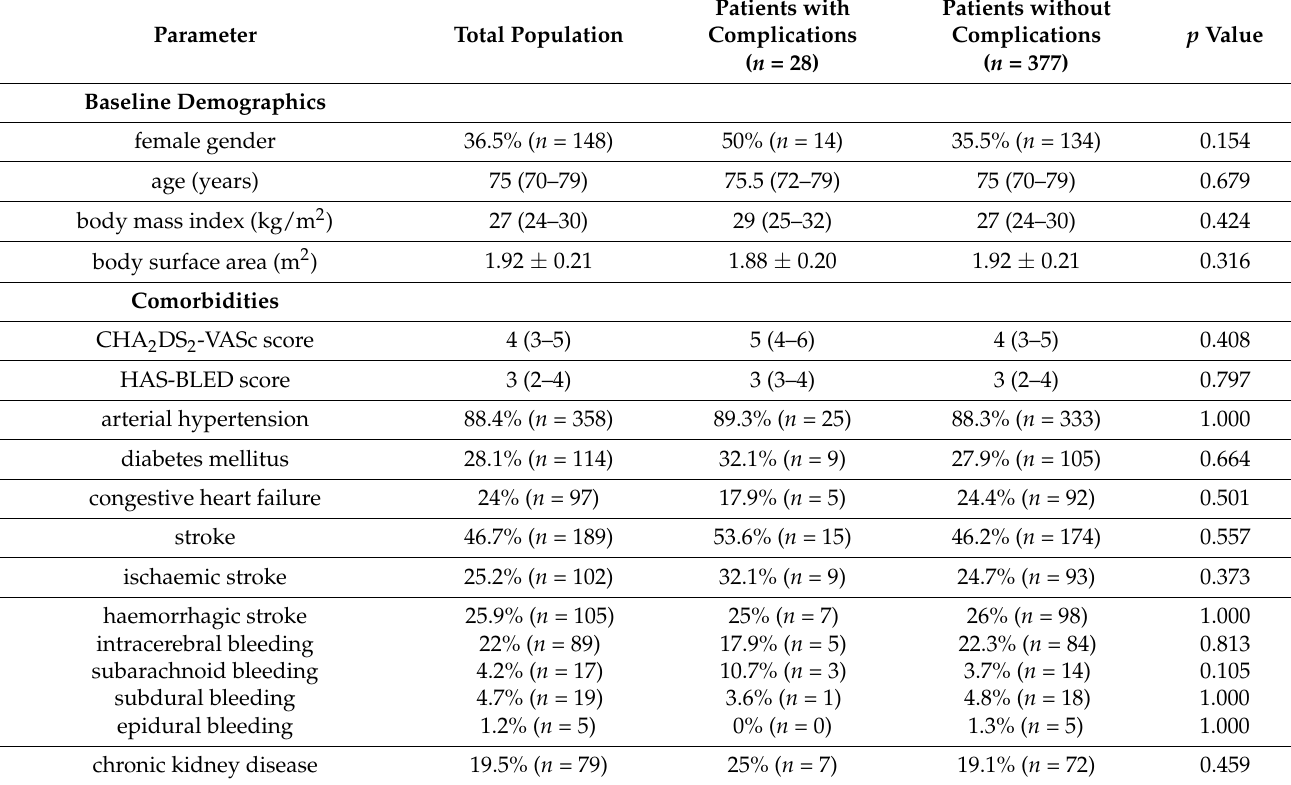
Table 1. Baseline